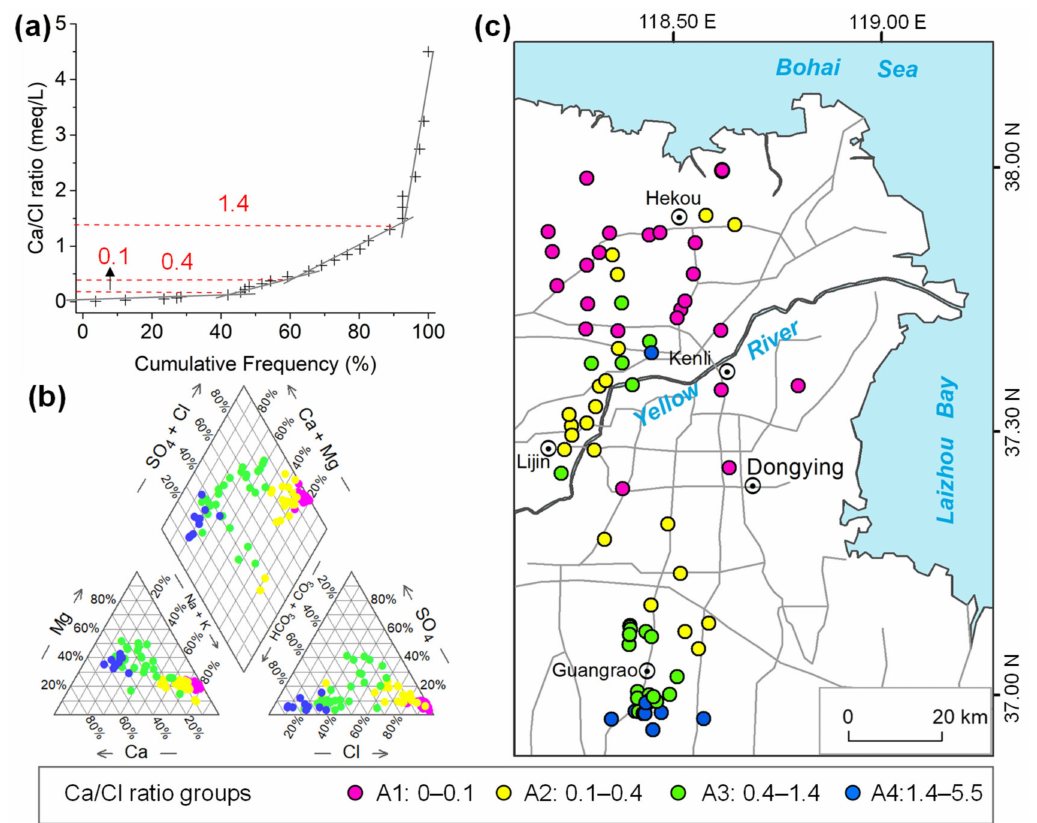
Figure 5. Cumulative frequency distribution curve for Ca/Cl ratios ( a ); representation of groupings on a Piper diagram ( b ); and distribution of Ca/Cl groups in the study area ( c